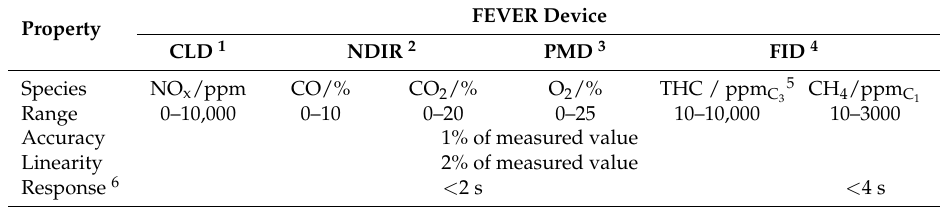
Table A1. Specifications of the standard gaseous exhaust analyzer (FEVER) [18].